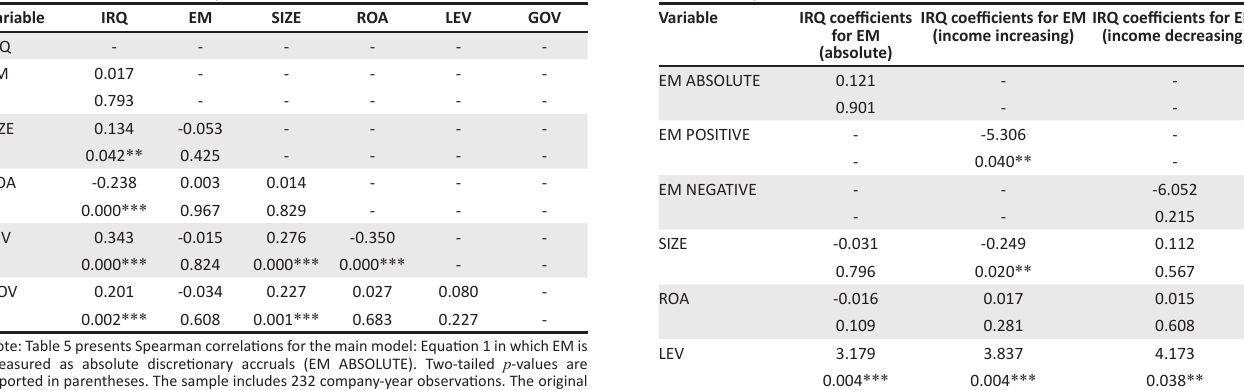
TABLE 6: Empirical results.